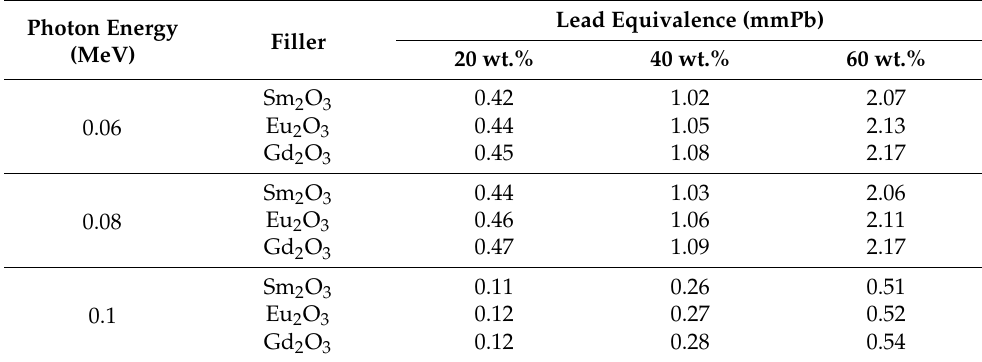
Table 7. Pb eq of Sm 2 O 3 /HDPE, Eu 2 O 3 /HDPE, and Gd 2 O 3 /HDPE composites with filler contents of 0, 20, 40, and 60 wt.%, determined at photon energies of 0.06, 0.08, and 0.1 MeV using